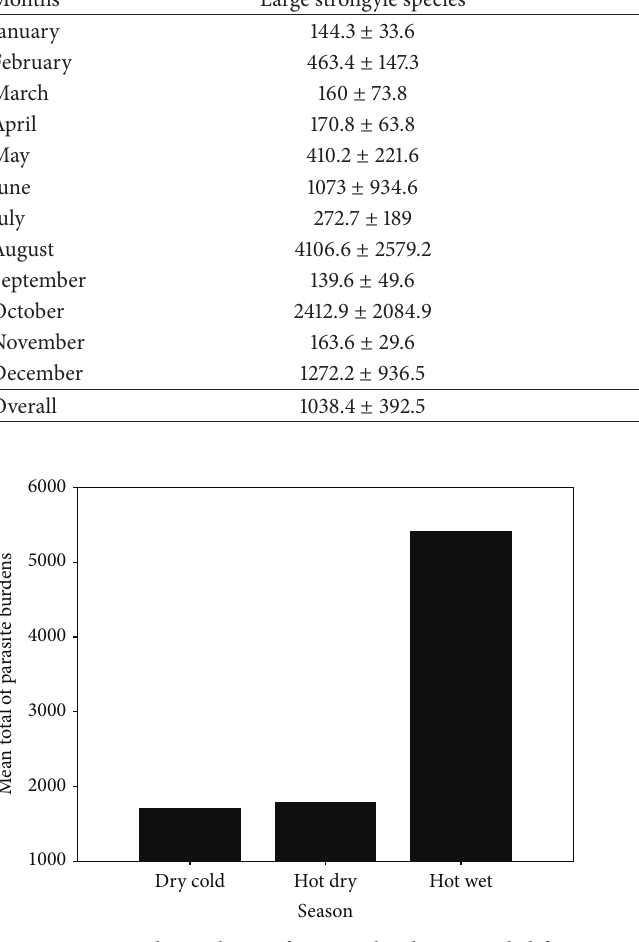
Figure 4: Seasonal prevalence of parasite burdens recorded from infected donkeys.